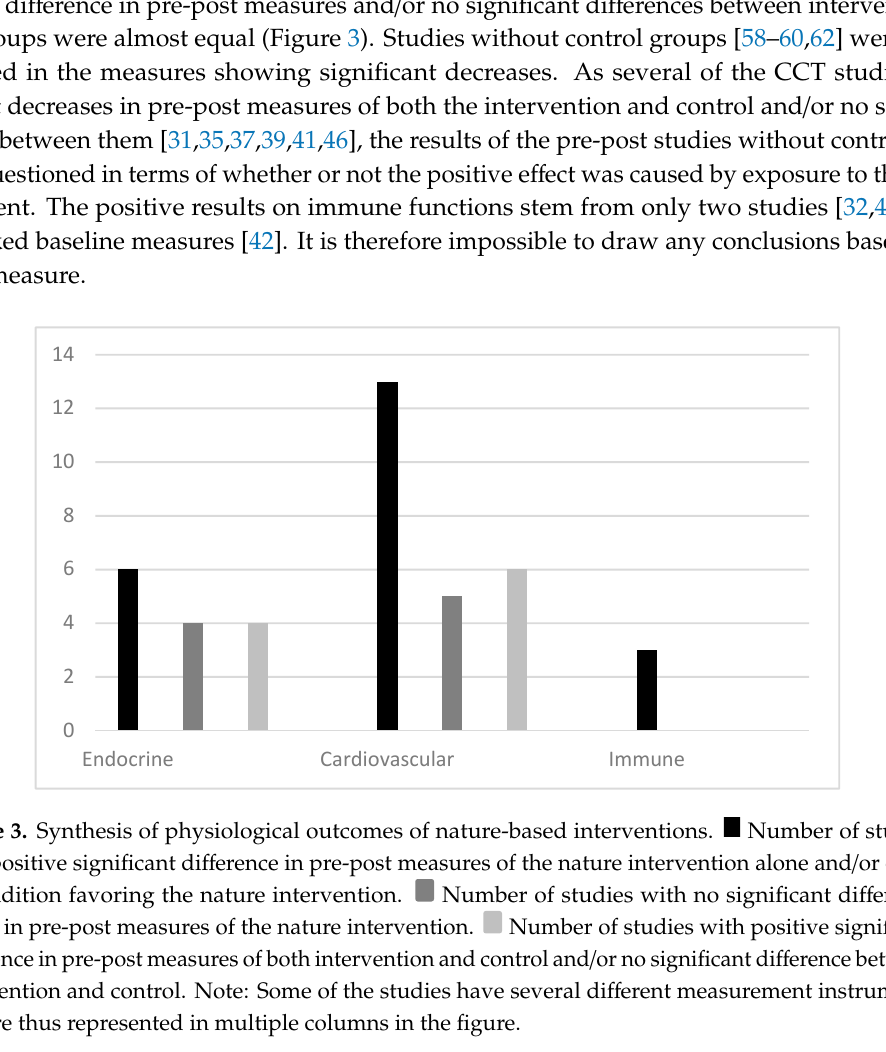
Figure 3. Synthesis of physiological outcomes of nature-based interventions.